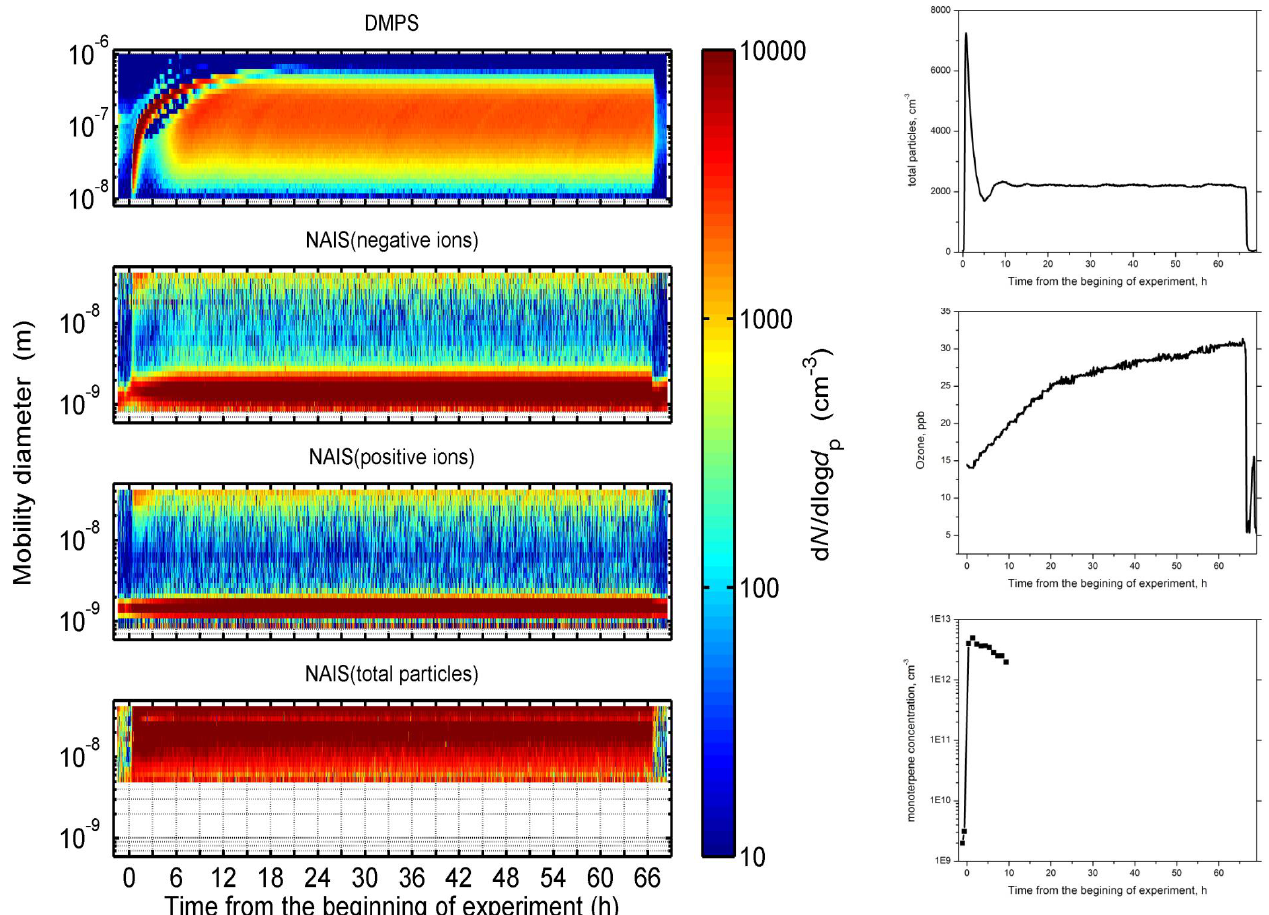
Fig. 6. Limonene curtain event on 7–10 November 2008. (a) DMPS plot showing all particles (neutrals + charged) from 10 to 1000nm. (b) a NAIS plot showing particles from 0.8 to 40nm. Top: negative particles; middle: positive particles; bottom: neutral + charged particles. (c) Top: total number of particles percm 3 , middle: Ozone concentration inppb , bottom: limonene concentration percm 3